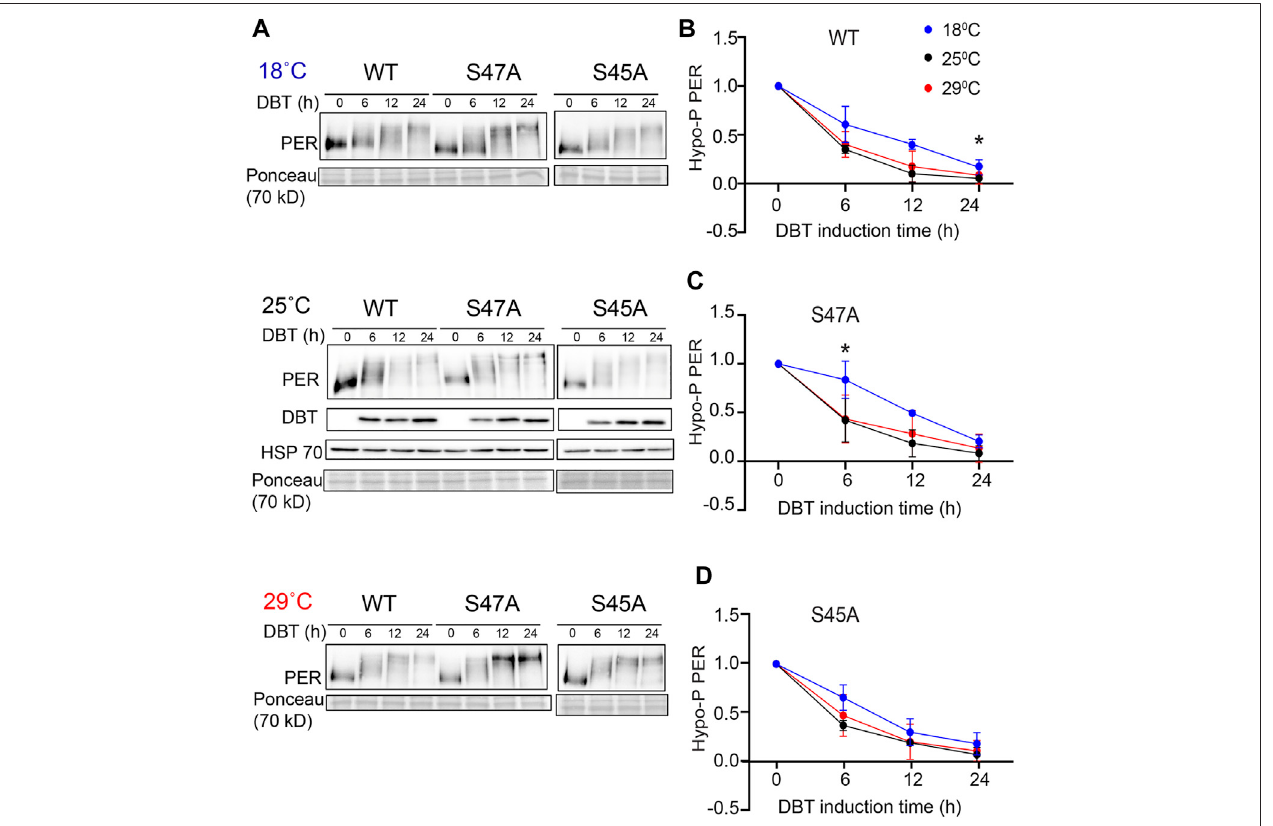
FIGURE 4 | S47A phosphorylation kinetics is slowed down at cold temperature. (A) Representative western blots probing cell extracts from S2 cells expressing DBT and either wild-type (WT) PER, S47A or S45A. Cells were incubated at the indicated temperatures, and collected at the indicated time points after DBT induction. ToppanelshowsPERimmunoblotting,bottompanelshowsPonceauSstaining,usedasloadingcontrolandfornormalization. (B – D) WesternBlotquanti fi cations.PER signal shown at time point 0 is used as a reference to classify PER isoforms as hypo-phosphorylated. Graphs representing the relative amount of hypo- phosphorylatedPERat18,25,and29 ° CfortherespectivegenotypesatdifferenttimepointsafterDBTinduction.S47Ashowsincreasedhypo-phosphorylatedPER6 h after DBT induction.* p < 0.05, 18 compared to 29 ° C, two-way ANOVAfollowed by Sidak ’ s multiple comparison to test for time and temperature-dependent differences ( n = 3 biological